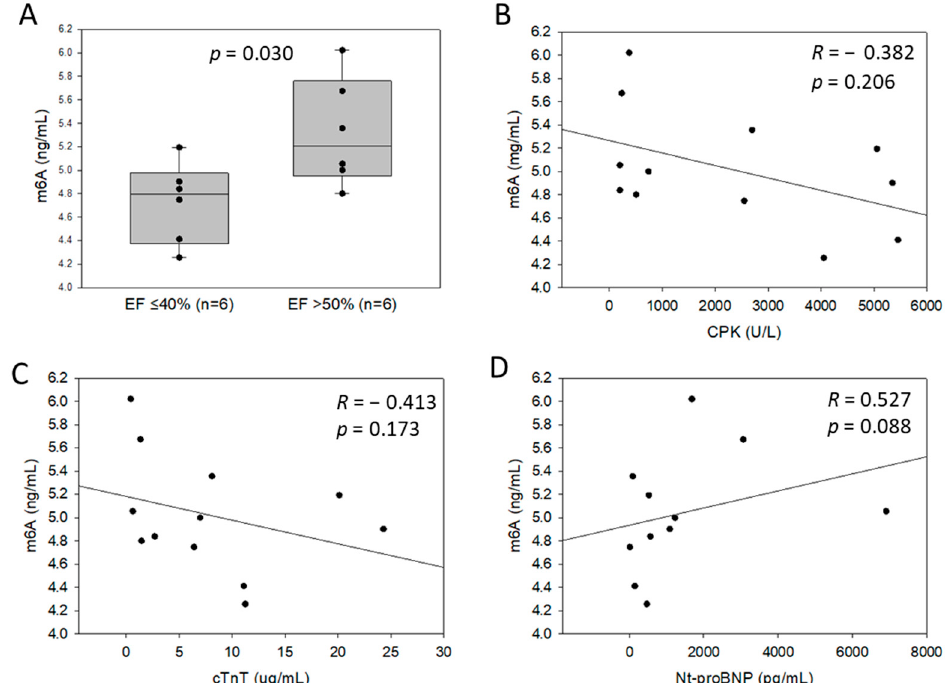
Figure 4. M6A levels in the blood of 12 patients after myocardial infarction (MI): association with ejection fraction (EF) ( A ), peak levels of cardiac markers CPK ( B ), cTnT ( C ), and admission levels of Nt-proBNP ( D ). Six patients developing heart failure 4 months after MI (EF ≤ 40%), and 6 patients with preserved EF (>50%) were included. M6A levels in total RNA extracted from whole blood samples collected at the time of reperfusion were quantified by LC-MS. Spearman correlation coefficients and p -value are indicated.